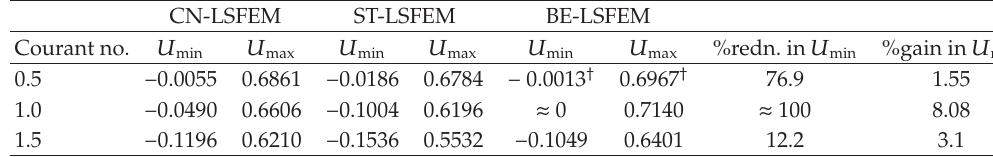
Table 1: Convection of Gaussian hill by t (cid:9) 0 . 6.